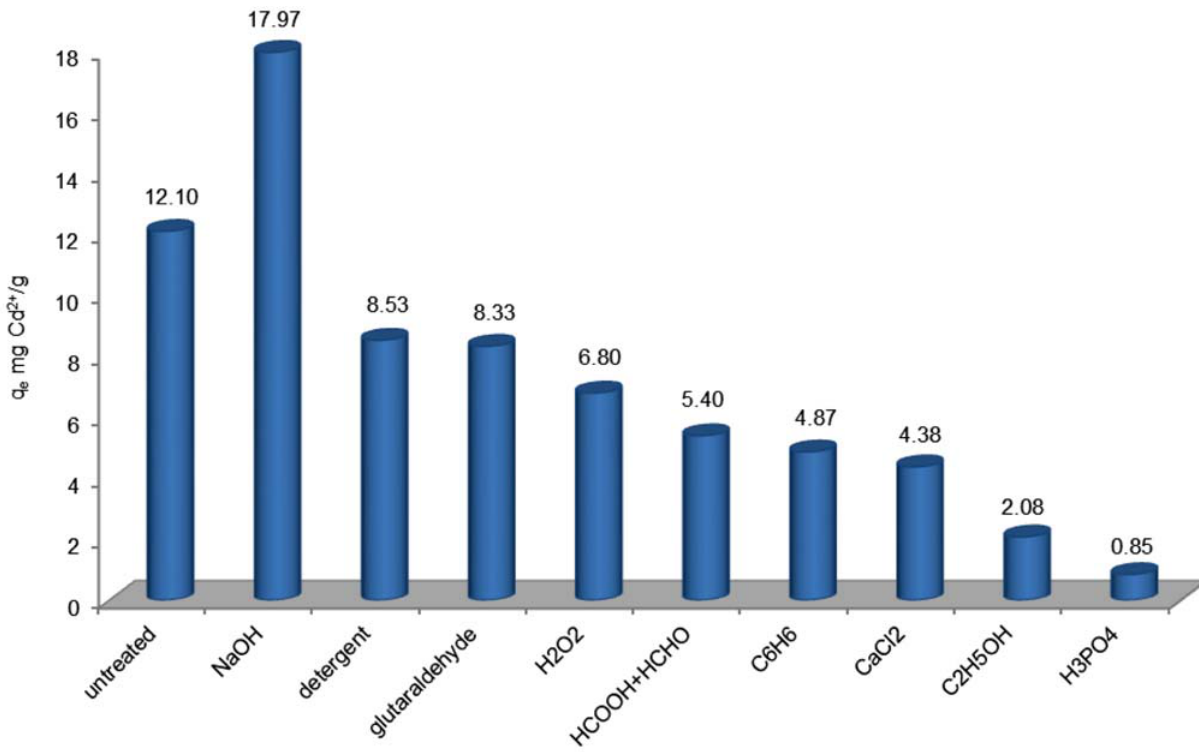
Fig. 3. Effect of different pretreatments on the Cd 2+ uptake of waste brewery yeast biomass; C °C, pH 5.6, 150 rpm.